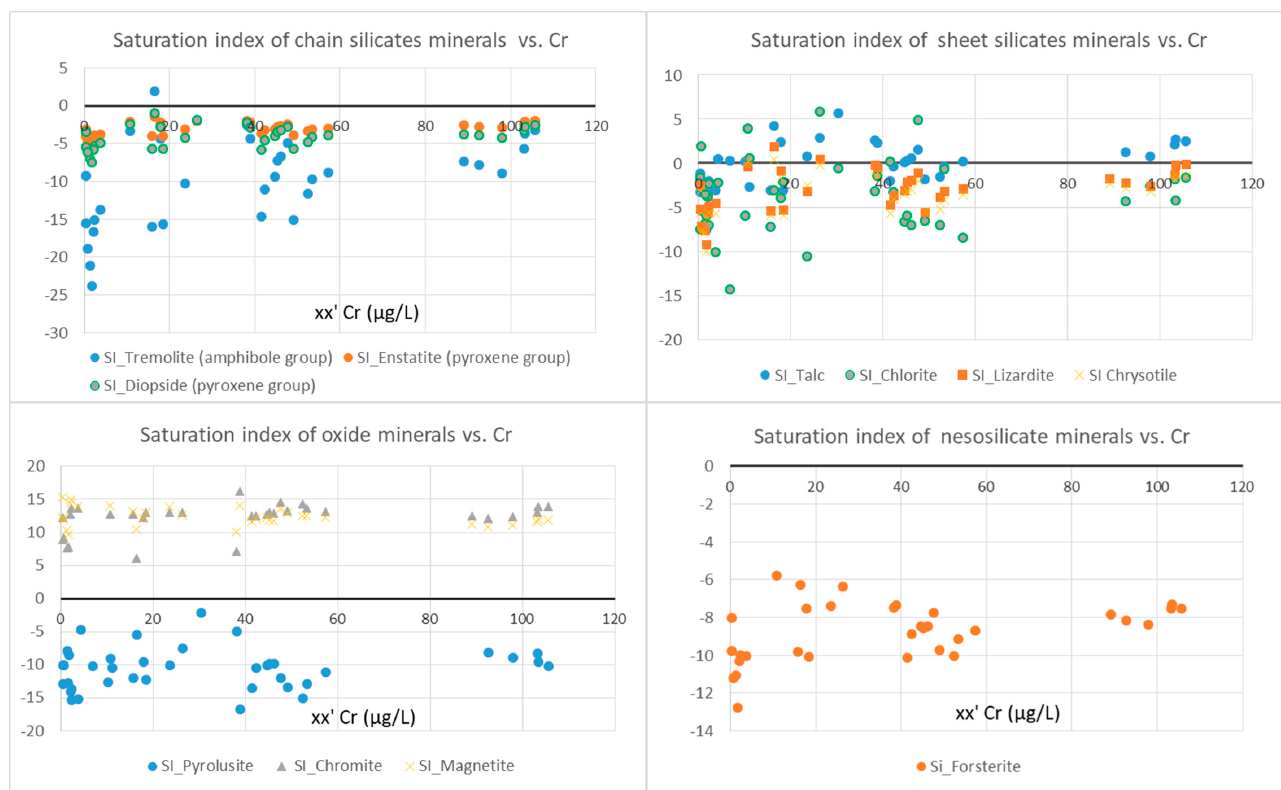
Figure 19. Plots of saturation indices vs. Cr of the natural springs in western Vermio Mt.